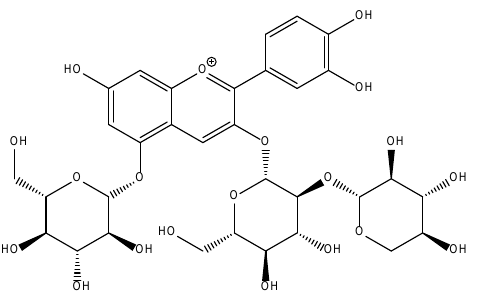
Figure 2. The identified chemical structure of an anthocyanin in red cabbage (Cy-3-soph-5-Glc).